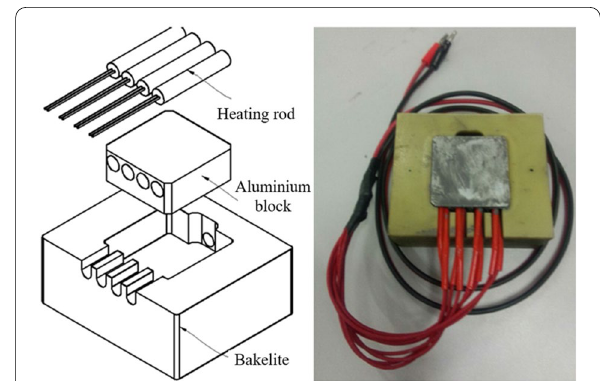
Figure 4 The heating module